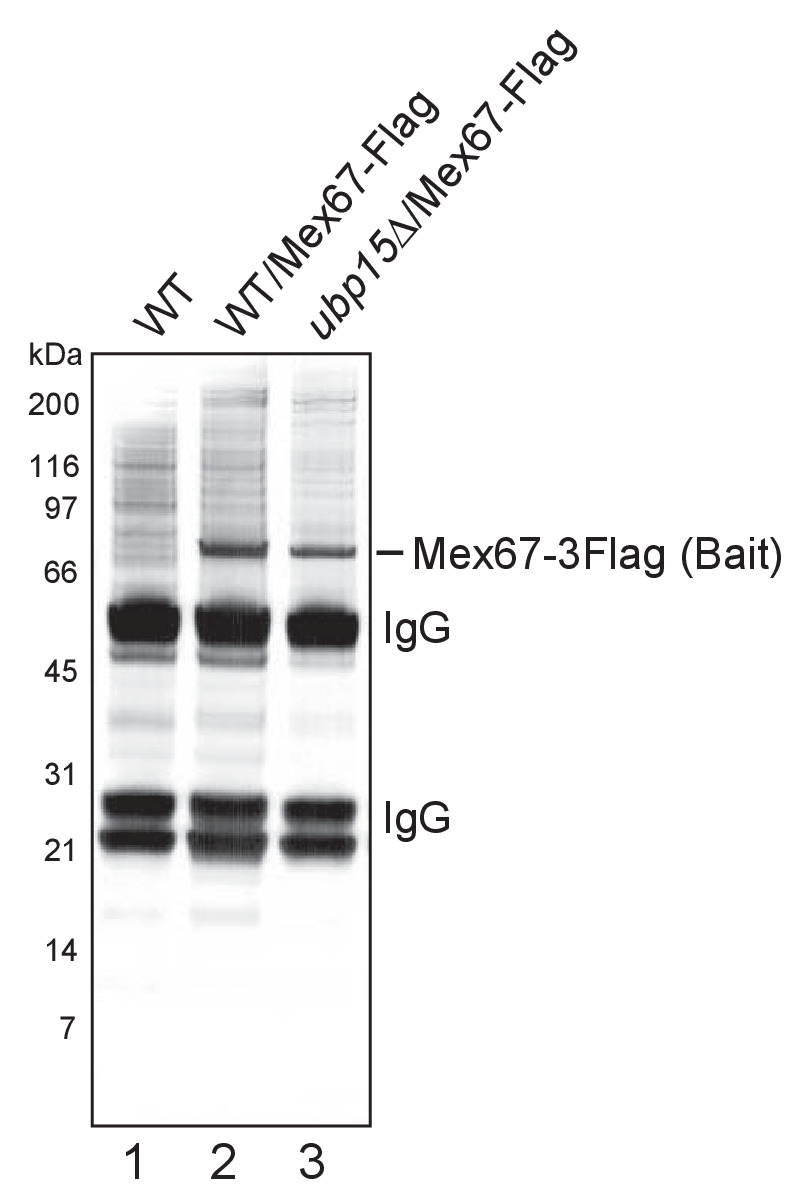
A silver-stained SDS-PAGE gel showing Mex67 complexes purified from WT and ubp15Δ cells.Lanes 1 and 2 are control purifications from cells non-expressing any Mex67-3Flag protein. The bait (Mex67-3Flag) and IgG (from the beads used to purify the complexes) are indicated.